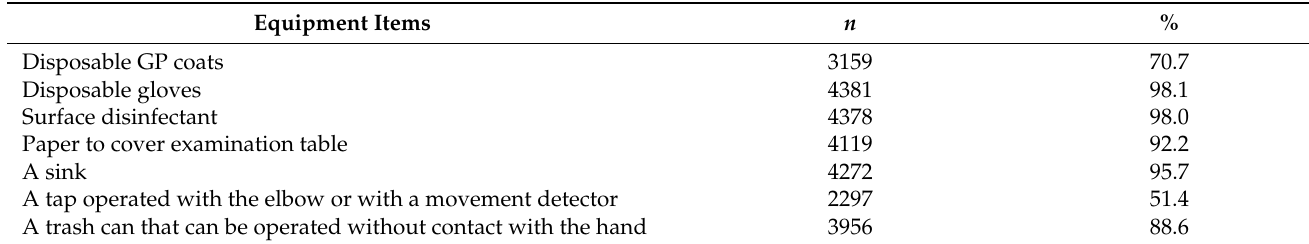
Table 3. Availability of equipment in every surveyed GP consultation room.